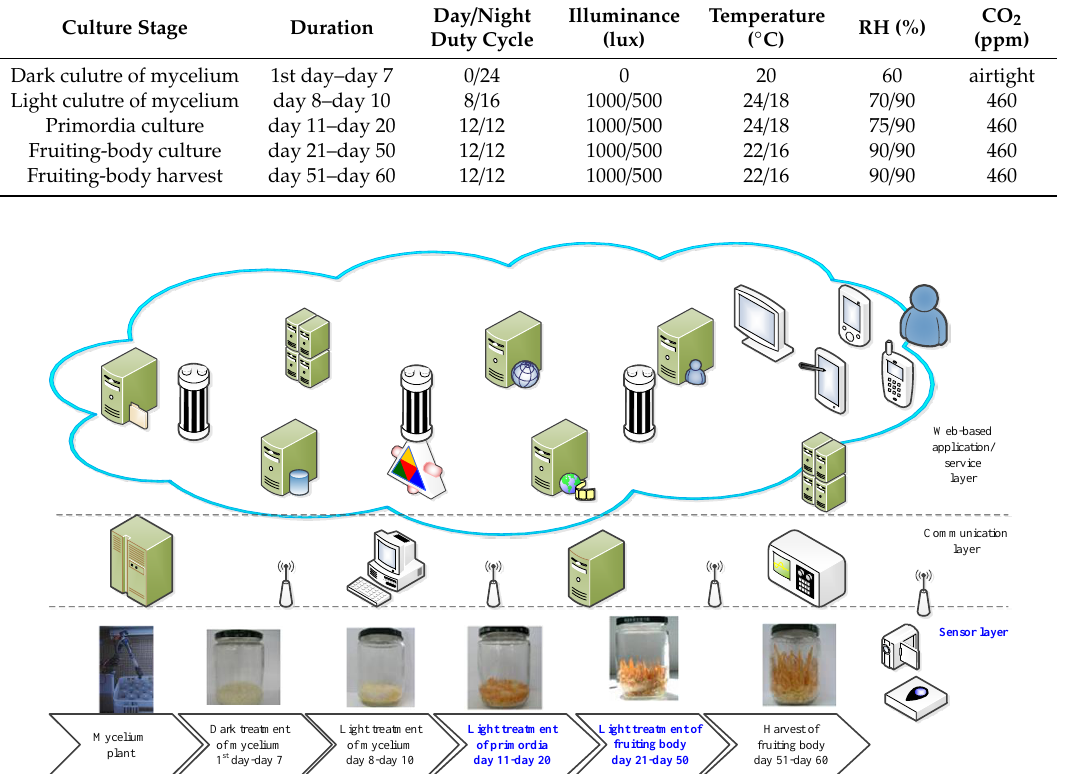
Figure 1. Configuration of wireless sensor network (WSN) system for C. militaris culture. Table 1. Cultivation conditions for whole course of solid-state fermentation (SSF) culture process of C. militaris .